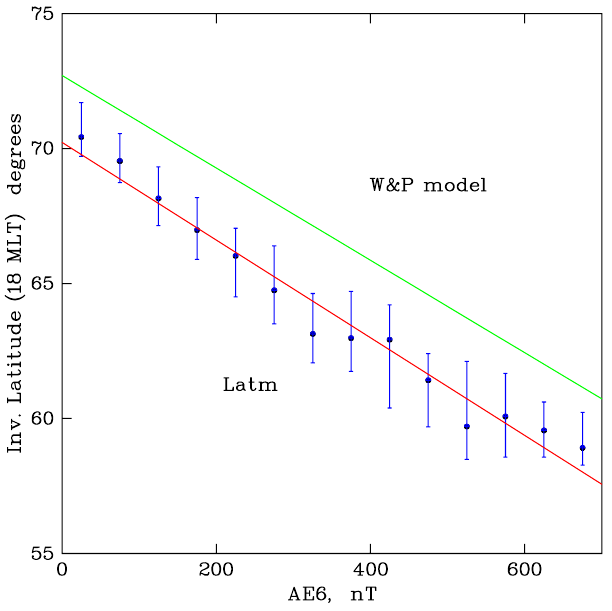
Fig. 12. Positions of the poleward boundary of the trough wall ( latm , red line) and the trough minimum (green line) as a func- tion of geomagnetic activity. The format of data presentation cor- responds to that of Fig. 3. The position of the trough minimum is specified according to the model of Werner and Pr¨olss (W&P, 1997).